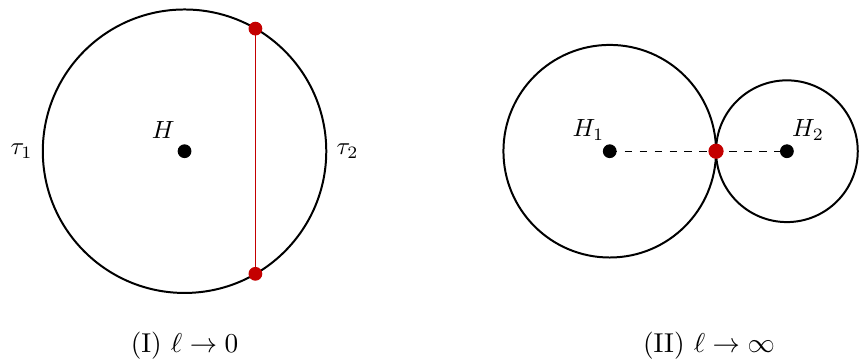
Figure 4 . Backreaction generated by an operator insertion (red dots) of dimension ‘ when ‘ ! 0 and ‘ ! 1 . We indicate the backreaction by depicting the deformations of the boundary curve in the Euclidean Poincare disk. We indicate the (local) horizons by a black